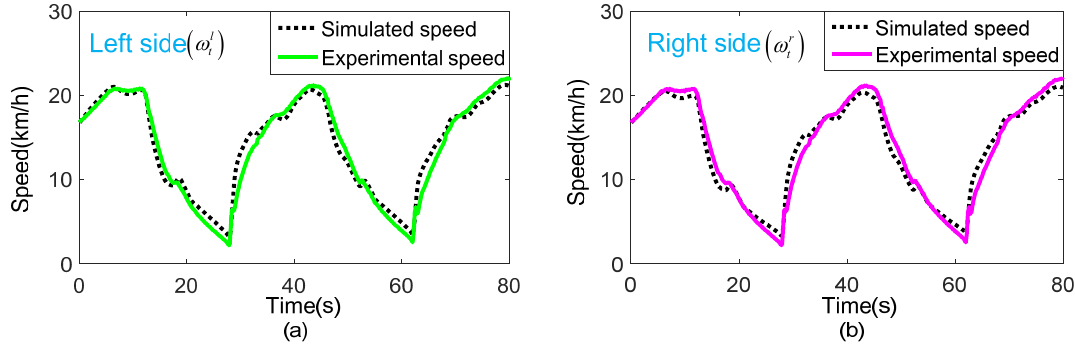
Figure 15 . Comparison of the actual speed obtained by the group 2 experiment and the simulation model with vehicle mass 30 t: ( a ) Left side actual speed; ( b ) Right side actual speed.